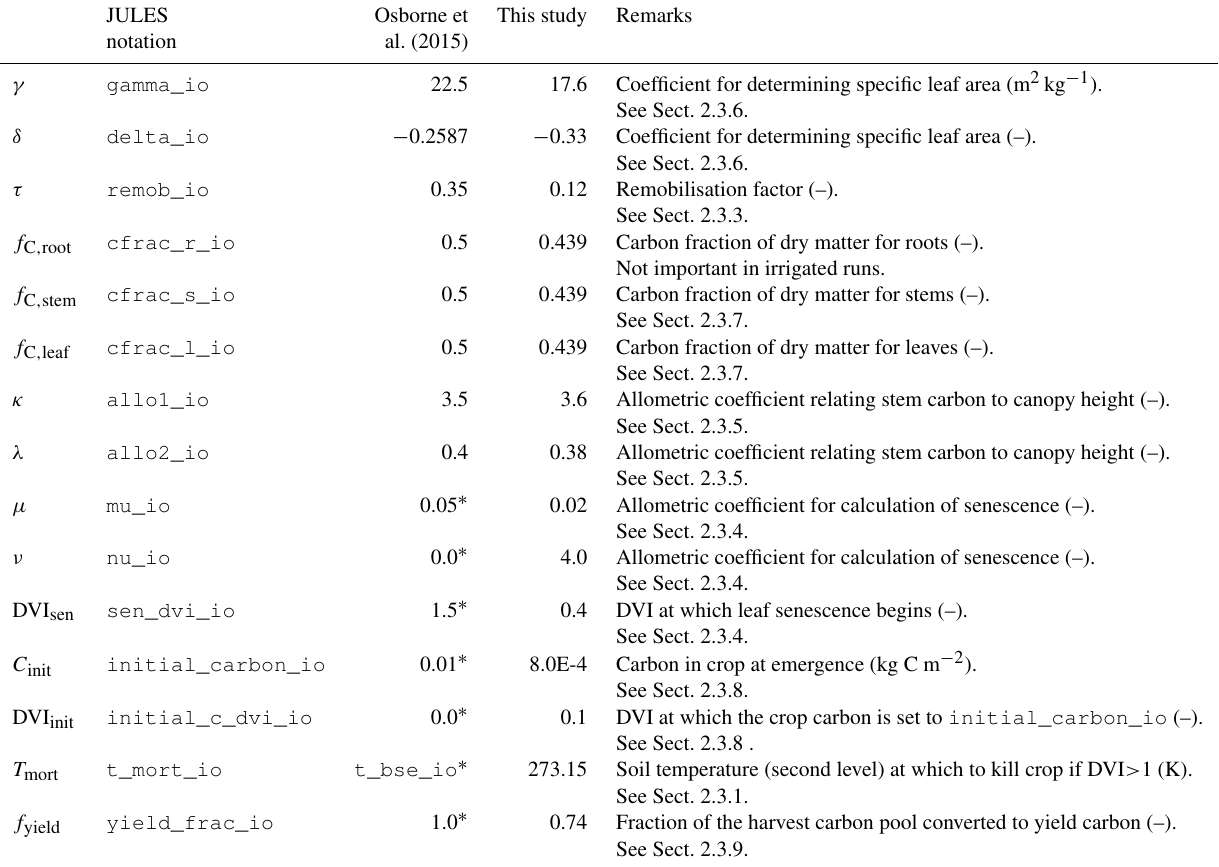
Table 4. Other relevant JULES parameter values. Units are given in brackets; (–) denotes dimensionless.